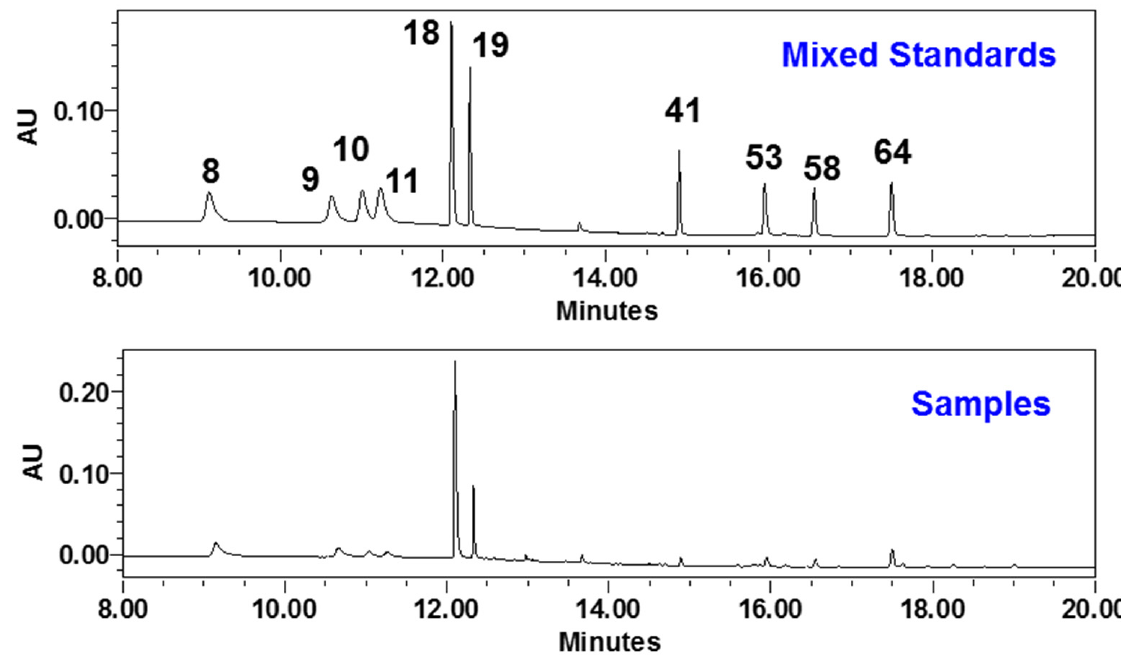
Figure 4. The LC/UV chromatograms of GDL Pill and mixed standards (270 nm).